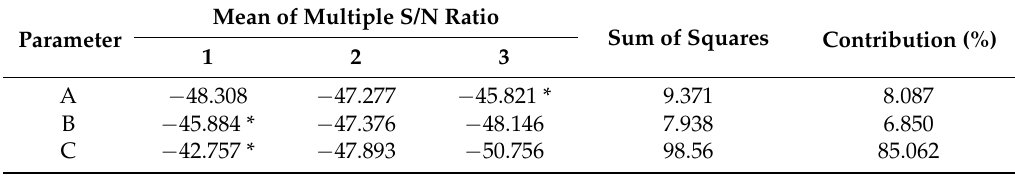
Table 8. Multiple S/N response.